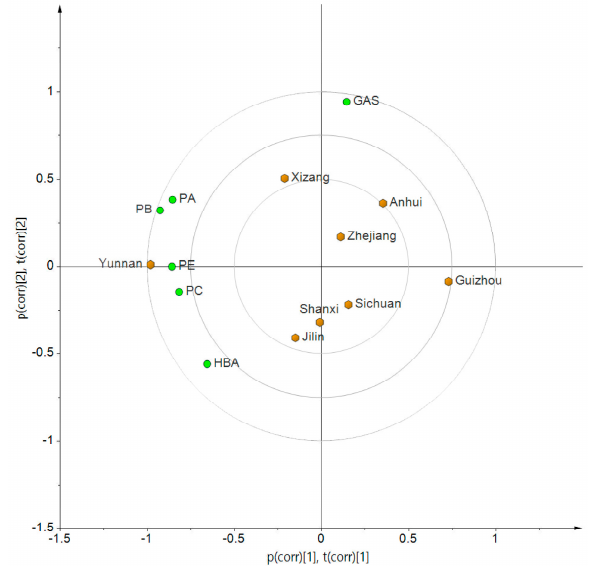
Figure 3. Biplot of the average content of GAS, HBA, PE, PB, PC and PA with eight localities of G. elata .